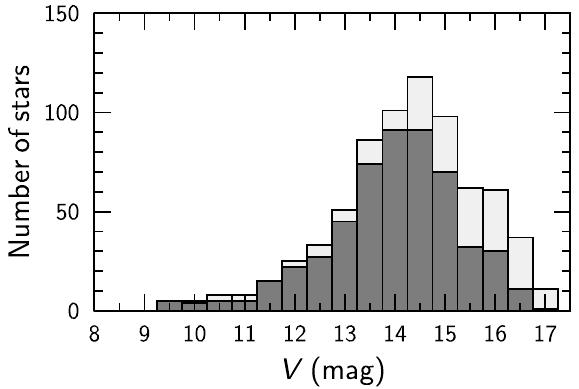
Fig. 2. Distribution of the measured stars in apparent magnitudes. The shadowed parts of the columns correspond to stars with two-dimensional classi(cid:12)cation. 3. THE